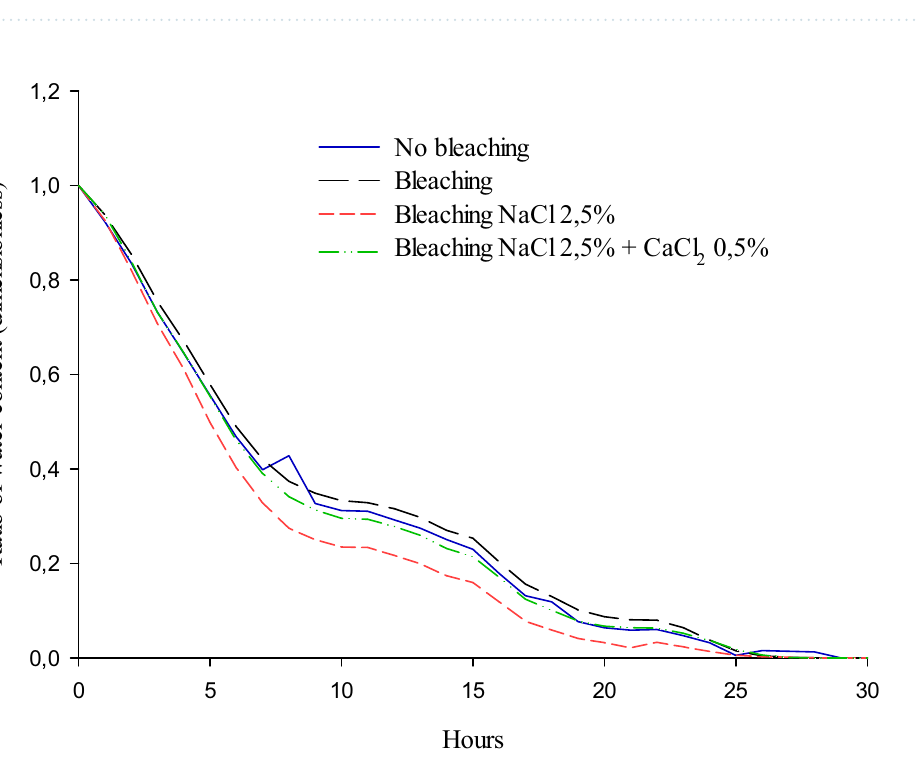
Table 1. Mathematical models parameters to represent tomato solar drying. T1 no bleaching, T2 bleaching, T3 bleaching in 2.5% NaCl solution, T4 bleaching in 2.5% NaCl and 0.5% CaCl 2 solution.